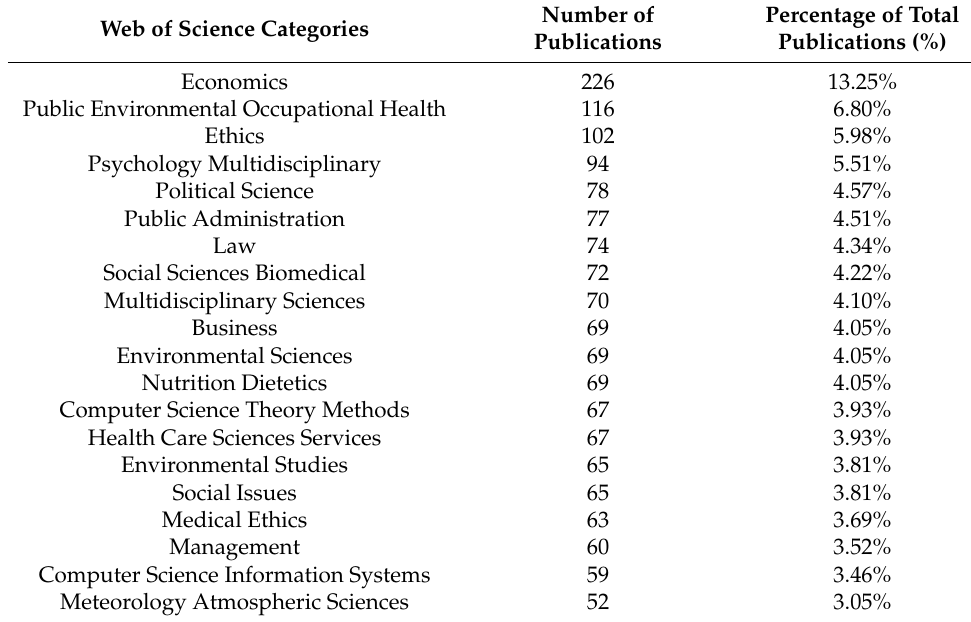
Table 2. Top 20 research categories of nudge